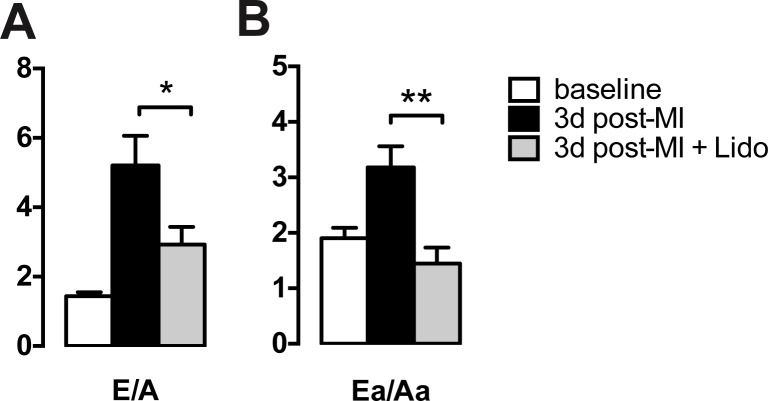
Lidocaine treatment attenuates diastolic dysfunction during ischemia.A + B Ratios of mitral inflow velocities (E/A) and mitral valve anulus velocities (Ea/Aa) are preserved following LAD ligation in mice receiving lidocaine (gray bars) as compared to mice receiving vehicle instead (black bars) and are comparable to preoperative values (white bars). p* = 0.0078, p**<0.0001.